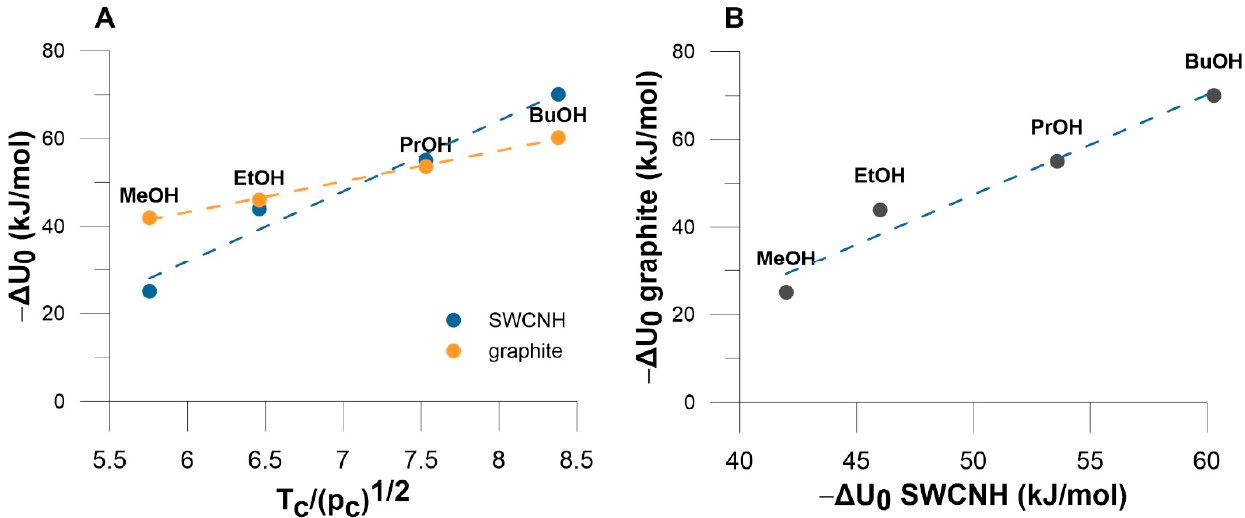
Figure 4. ( A ) The plot of isosteric enthalpy at zero coverage on graphite and on SWCNH in the coordinates of Equation (3). The values of determination coefficients (DC) are equal to 0.9963 and 0.9693 for correlation on graphite and SWCNH, respectively. ( B ) The comparison of enthalpy on zero coverage on graphite and SWCNH (DC = 0.9527).